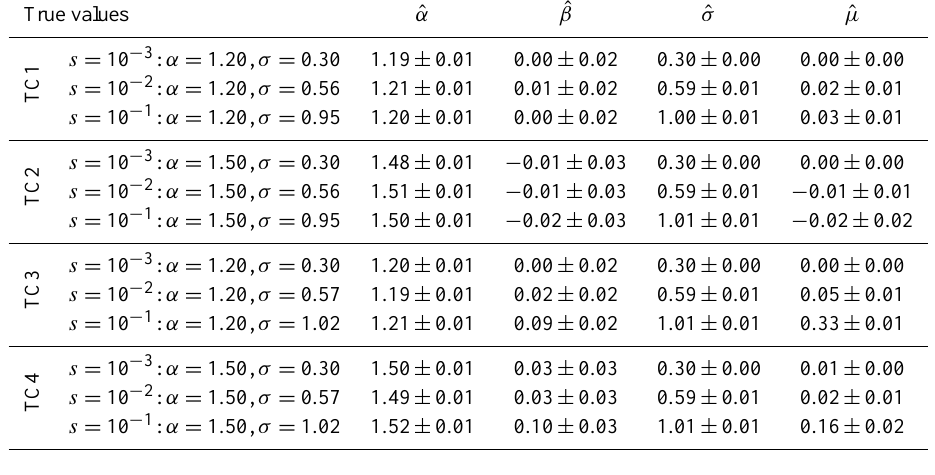
Table 1. True and ML-estimated parameters of tfGn signals. True values of β and µ are equal to zero in all test cases. True values ˆ α ˆ β